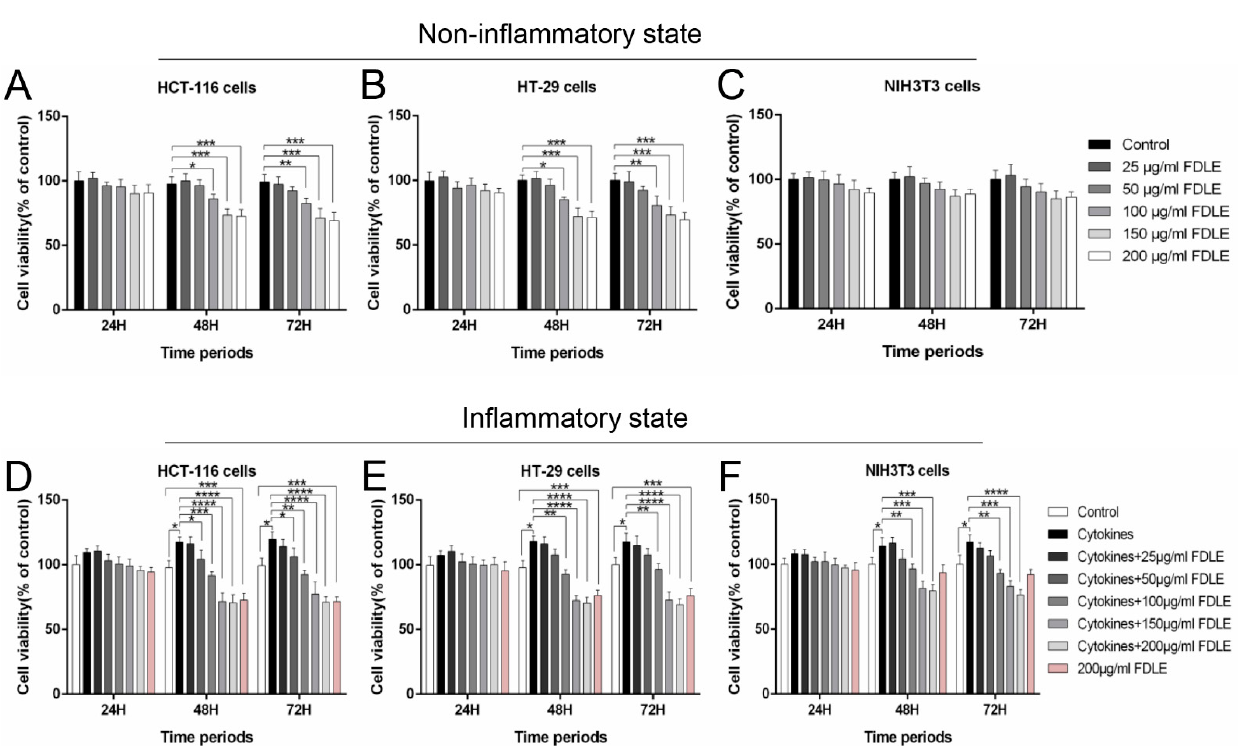
Figure 2. The effects of FDLE on cell viability of colorectal cancer cell lines (HCT-116 and HT-29) and normal mouse embryonic fibroblast cell (NIH3T3) in non-inflammatory and inflammatory states by MTT. The cells were treated with various concentrations of FDLE for 24, 48 and 72 h. The cell viability was calculated comparing to untreated control cells after 24, 48 and 72 h of incubation. ( A – C ) The cell viability of HCT-116, HT-29 and NIH3T3 cells in non-inflammatory state. ( D – F ) The cell viability of HCT-116, HT-29 and NIH3T3 cells in inflammatory state. The results were repre- sented as mean ± SD of three independent experiments, * p < 0.05, ** p < 0.01, *** p < 0.001, **** p < 0.0001. 3.2. Effects of FDLE on Growth Inhibition in Colorectal Cancer Cell Lines by Colony Formation Assay According to the results of MTT assay, FDLE tended to reduce proliferation in HCT- 116 and HT-29 colorectal cancer cell lines in both normal and inflammatory conditions. Therefore, the inhibitory effect of FDLE on seven days’ growth of these cell lines was ex- amined. The colony number of HCT-116 and HT-29 are shown in Figure 3. FDLE signifi- cantly reduced the colony number of HCT-116 and HT-29 cells in normal condition in a dose-dependent manner, when compared to untreated cells (Figure 3A–C). In inflamma- tory condition, mixture of TNF- α , IFN- γ and LPS significantly increased colony number of both HCT-116 and HT-29 cells, while in the FDLE treatment, the colony formations were both significantly reduced in a dose-dependent manner, when compared to cyto- kines-treated cells (Figure 3D–F). The growth inhibition rates of 200 µg/mL FDLE on HCT- 116 cells in normal and inflammatory conditions were 47.8% and 58.4%, and HT-29 cells were 46.5% and 56.9%, respectively (Supplementary Table S2). The results indicated that FDLE revealed inhibitory effects against normal growth colorectal cancer cells together with the growth under inflammatory conditions, whereas the inhibitory effect was more observable in inflammatory condition.